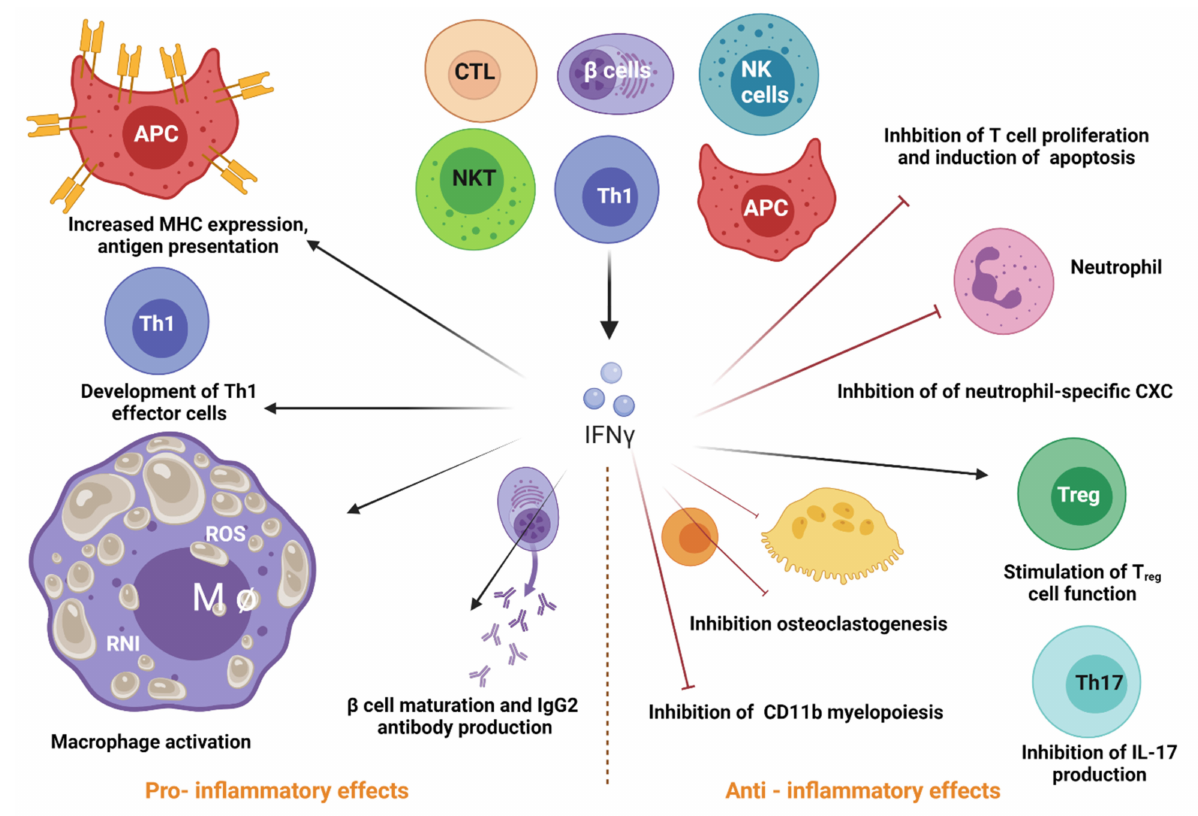
Figure 2. Roles of Type II Interferons. IFN type II is a pleiotropic cytokine that participates in viral response and regulating innate and adaptive immune responses. NK cells, T cells, B cells, APC release this cytokine to function both as an inducer (pro-inflammatory) and a regulator (anti-inflammatory) of immune responses. Regarding the pro-inflammatory effects, IFN- γ has a strong macrophage-activating activity and induces B cell maturation and IgG2 production. Additionally, this cytokine stimulates antigen presentation via MHC, development of Th1 effector cells, and cell function of T reg cells. The anti-inflammatory effects of IFN- γ include the inhibition of T cell-dependent osteoclastogenesis and production of IL-17, which leads to decreased levels of neutrophil-specific CXC chemokines and limited mobilization of neutrophils. Furthermore, type II IFN inhibits myelopoiesis of CD11b + leukocytes, T cell proliferation and induces apoptosis by secreting nitric oxide (NO) and indoleamine 2,3-dioxygenase (IDO). All these anti-inflammatory properties contribute to the protective role of IFN- γ against autoimmune diseases. Created with